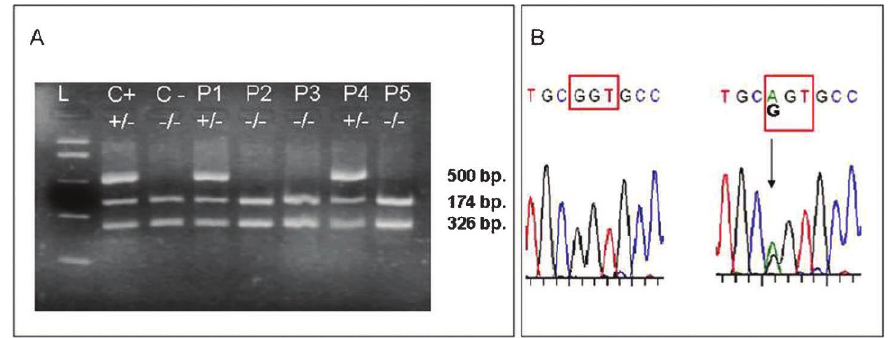
Figure 1 - (A) Gel electrophoresis of PCR fragments after digestion with Ban I for identification of the G12S polymorphism of the SDHD gene by RFLP (L = DNA ladder; C + = positive control; heterozygote for G12S; C- = negative control; G12 normal, P1–P5 = patients. (B) Chromatograms of exon 1 of the SDHD gene showing the wild type and the heterozygote form of the G12S (GGT12AGT) polymorphism.